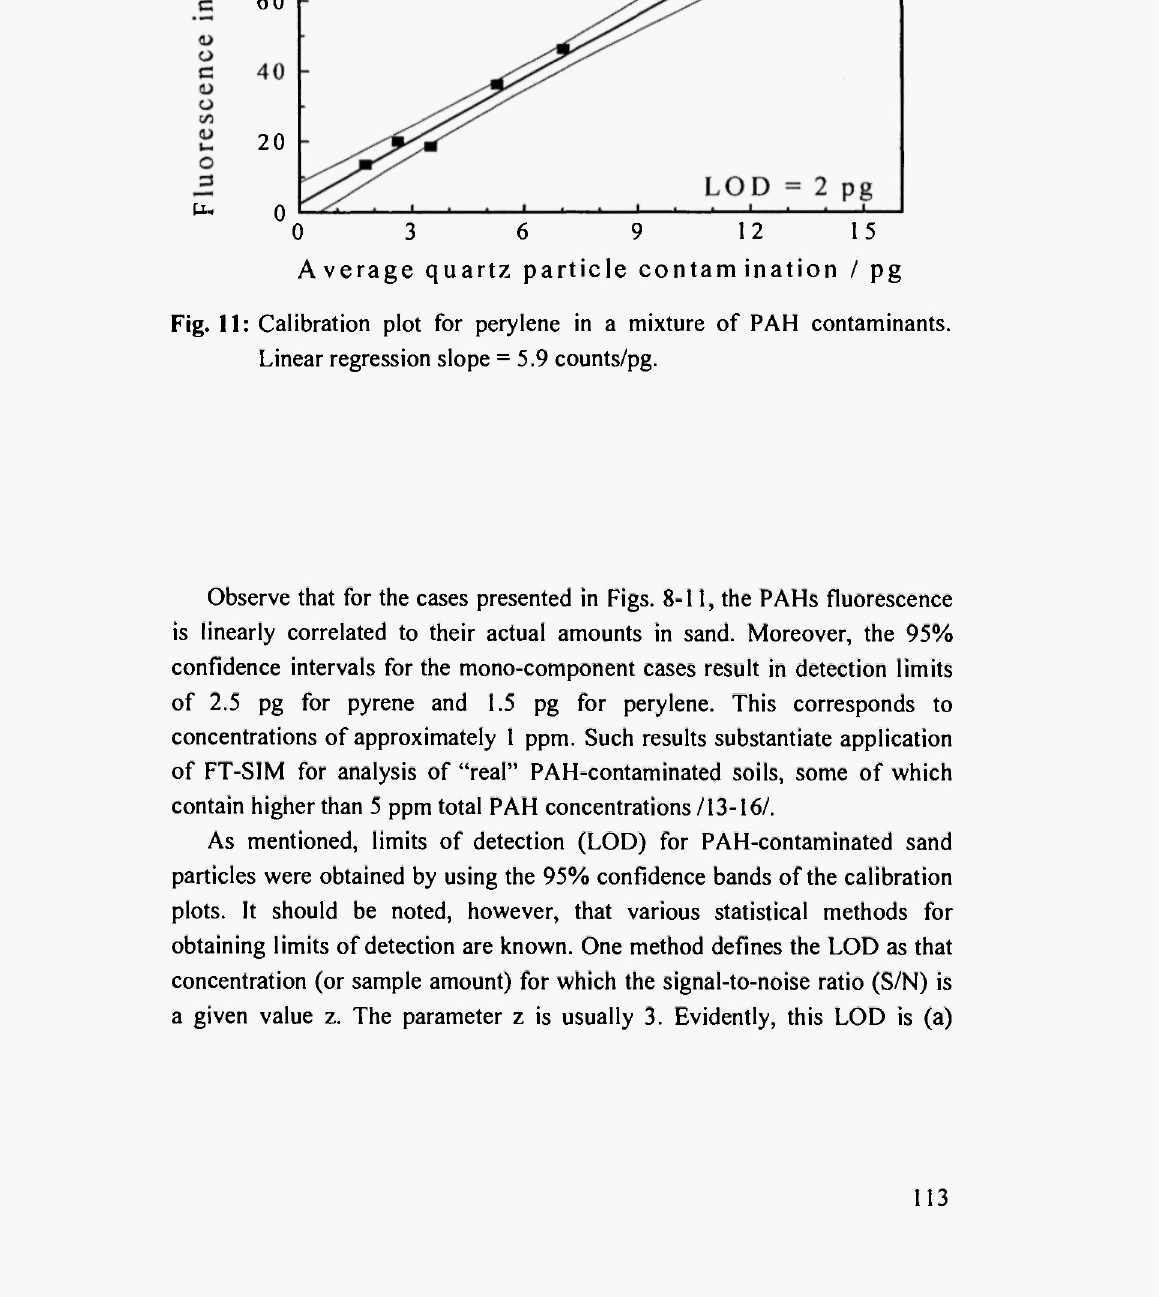
Fig. 11: Calibration plot for perylene in a mixture of PAH contaminants. Linear regression slope = 5.9